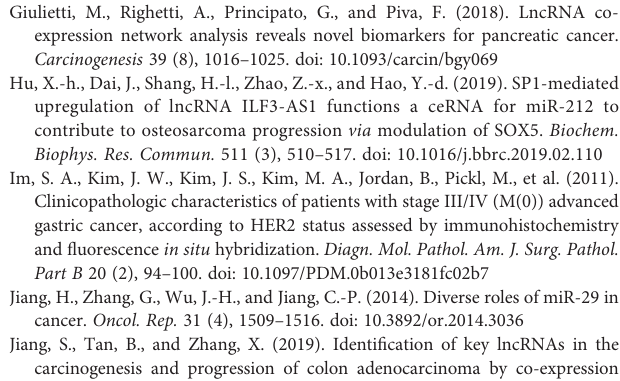
SUPPLEMENTARY FIGURE 1 | Network topology for soft-thresholding powers. The power numbers in the plots indicate soft thresholding value. The approximate scale-free topology can be selected by the power=4.